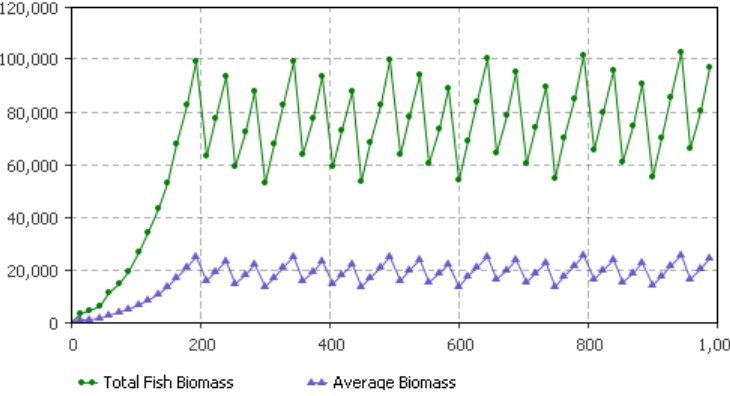
Figure 11. Average biomass per fish tank and total fish biomass of all fish tanks (in g; y ‐ axis) in the RAS for the first 1000 days ( x ‐ axis). Fish biomass peaks every 50 days corresponding to the proposed harvest schedule.